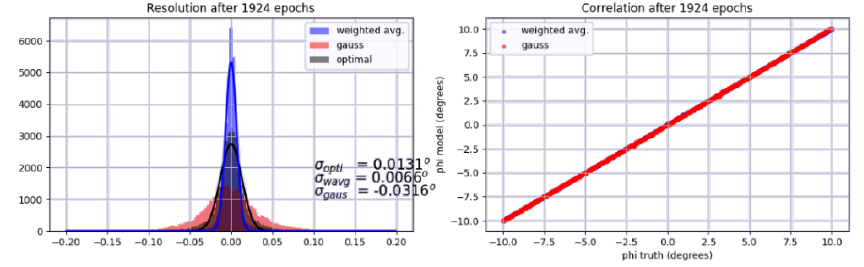
Figure 2. On the left the resolutions are shown for the weighted average method, a Gaussian fit method and a theoretical optimum. The right plot shows the comparison between the true value of the angle and the value obtained by the model for the two methods of value extraction; it shows good agreement between all methods.